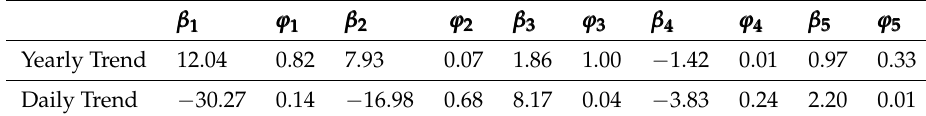
Figure 5. Historical spot prices, histogram, ACF and decomposed prices. Table 2. Yearly and daily components.